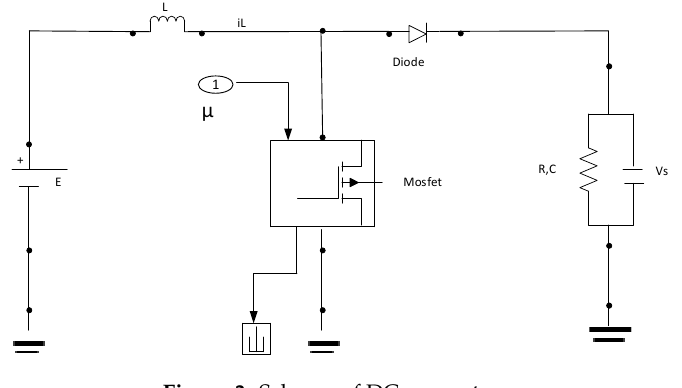
Figure 3. Scheme of DC converter.